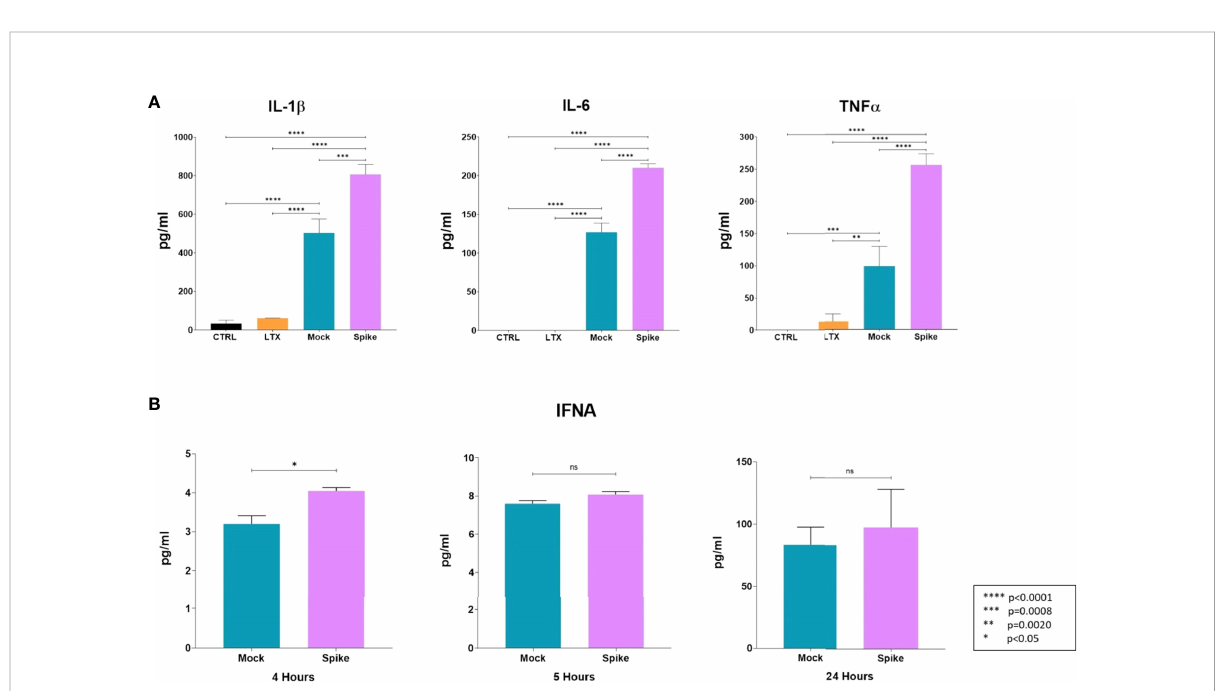
FIGURE 6 Early changes in the cytokine pro fi le induced by the S protein. (A) Protein levels of IL-1 b , IL-6, and TNF- a in medium of transfected cells. Results are concluded from triplicate measurements. (B) Time-point analysis of levels of IFNAs from media of transfected cells. Results are concluded form duplicate measurements. Error bars indicate SEM. ns, non-signi fi